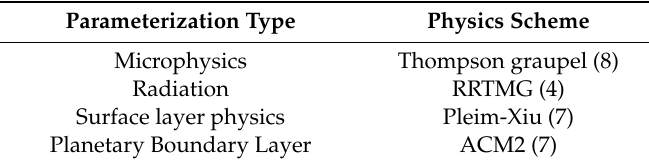
Table 2. WRF model parameterization name and namelist